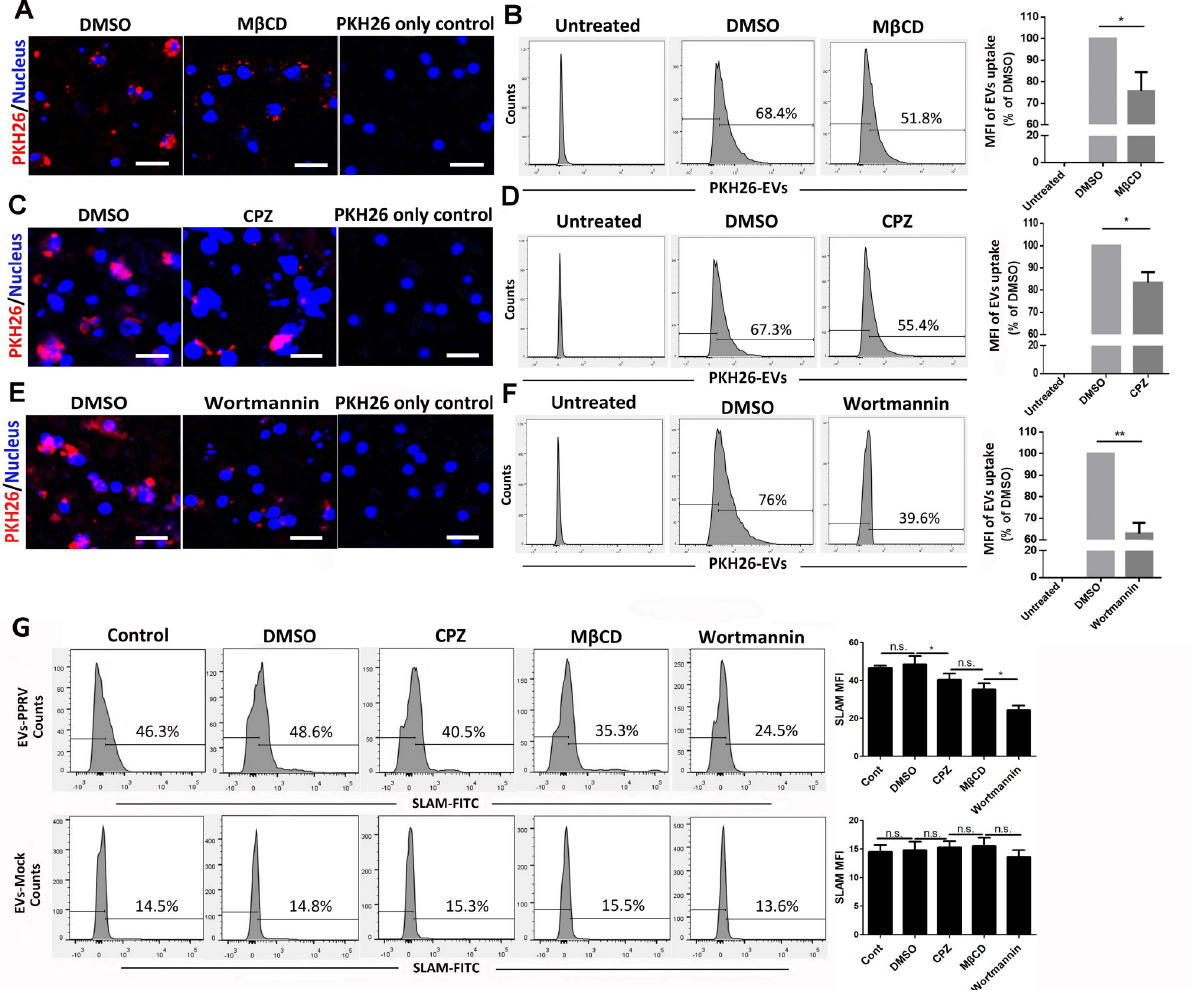
Fig 7. Extracellular vesicles were internalized into the recipient cells via classical endocytic pathway. (A, C, E) Goat PBMCs were pretreated with M β CD (A), CPZ (C), or wortmannin (E) for 1h at 37˚C and then incubated with PKH26 labeled-EVs-PPRV for 6h. After removal of surface-bound EVs and ligands, internalized EVs were analyzed by using a confocal laser scanning microscope. The nuclei were stained with Hoechst 33342. PKH26-labeled PBS were used as PKH26-only negative control. (B, D, F) Goat PBMCs were pretreated with M β CD (B), CPZ (D), or wortmannin (F) for 1h at 37˚C and then incubated with PKH26 labeled-EVs-PPRV for 6h. After removal of surface-bound EVs and ligands, internalized EVs were analyzed by using flow cytometry. DMSO-treated cells and untreated cells were used as positive and blank control, respectively. (G) Goat PBMCs pretreated with M β CD, CPZ, or wortmannin for 1h were co-cultured with equal quantities of EVs-PPRV or EVs-Mock for 48 h, respectively. Then, SLAM expression on the recipient cells were analyzed by flow cytometry. Scale bar = 30 μ m. Data are given as means ± standard deviation (SD) from three independent experiments. P values were calculated using Student’s t test. An asterisk indicates a comparison with the indicated control. � , P < 0.05; �� , P < 0.01; n.s., not